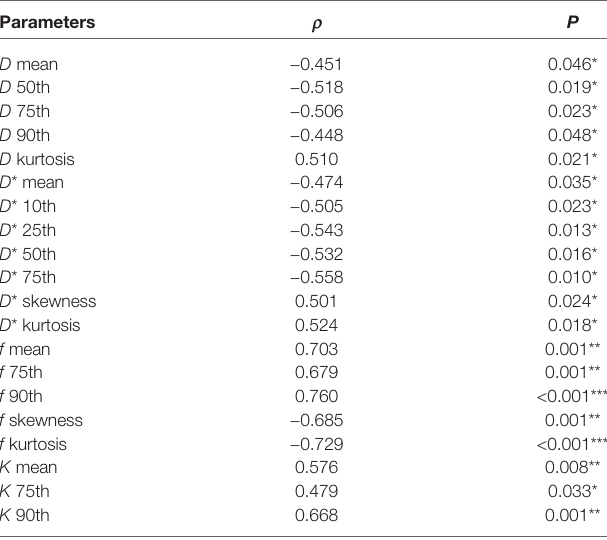
TABLE 5 | Spearman correlation of histogram IVIM-kurtosis and MEM parameters to tumor GS (with P < 0.05). Parameters r